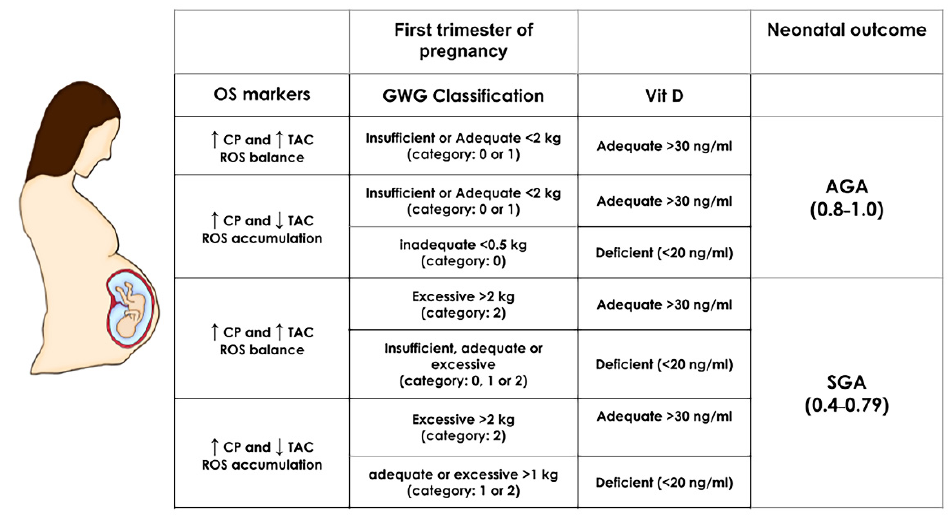
Figure 3. First-trimester SGA and AGA simulations in normal weight pregnancies. The prediction of neonatal outcome was calculated by manipulating the most important maternal predictors: oxidative stress biomarkers (OS markers CP and TAC), gestational weight gain (GWG), and vitamin D (Vit D) in normal weight pregnancies (the pBMI value was set at 24 kg/m 2 and kept constant). The range for an SGA outcome is a numeric result between 0.4–0.79 and for AGA within 0.8–1.0 (based on the ANN algorithm Equation (A3) (Appendix A) and the scatter plot from Figure 1). Depicted are the values of maternal factors leading to an SGA or AGA result. GWG, gestational weight gain; MDA: Malondialdehyde; TAC: Total antioxidant capacity; AGA: Appropriate for gestational age; SGA: Small for gestational age.